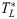
Modelling thermotaxic individuals.(A) A snapshot of the model, showing twelve simulated pups (small circles) in a circular arena (large circle), with orientations indicated by arrows. In this snapshot, pups are shown aggregated, often overlapping, and a focal pup is highlighted by a black body and a white *. (B) The same snapshot is shown, zoomed in on the focal pup. The left and right sides of its body are coloured green and blue respectively, to indicate the regions of the body surface over which average temperatures constitute the left and right sensor values TL* and TR*. To implement thermotaxic control, these sensor values set the drive speed of contralateral motors ML* and MR*, which change the position x and orientation θ of the pup. (C) For the focal pup, the temperature (τ) registered at discrete positions around the body circumference (indexed by k) is shown. For the focal pup TR* is greater than TL*, indicating that it is warmer on the right than the left, hence at this point in time ML*>MR* and therefore the pup will orient clockwise. See Models for precise definitions of these terms.